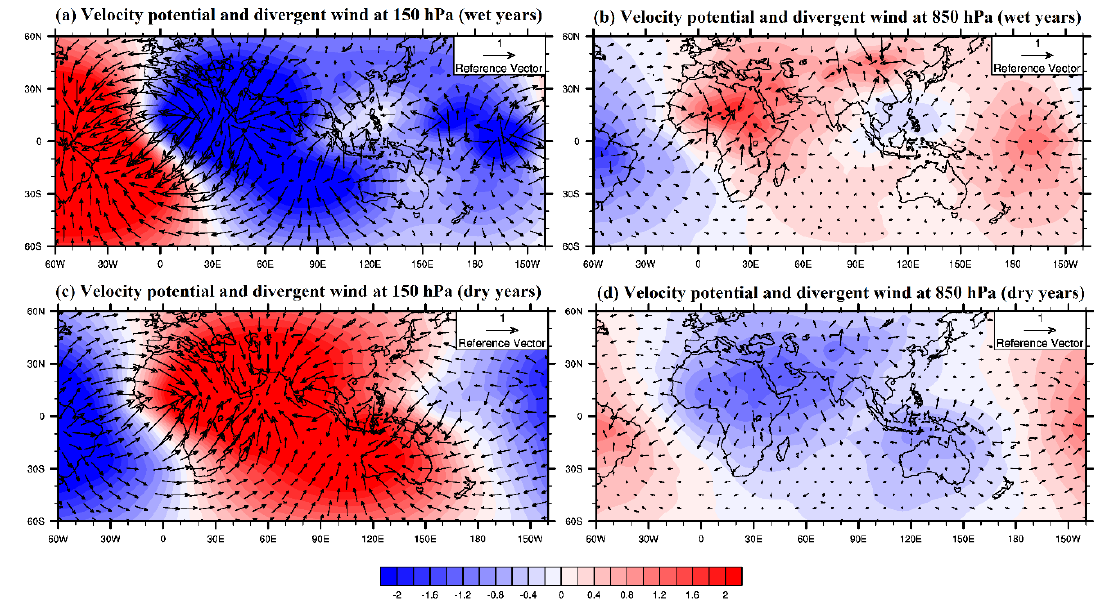
Figure 5. Velocity potential (10 − 5 m 2 s − 1 ; shaded) and divergent wind anomalies (m s − 1 ; vectors) for wet ( a , b ) and dry ( c , d ) years at 150 hPa ( a , c ); and 850 hPa ( b , d ).